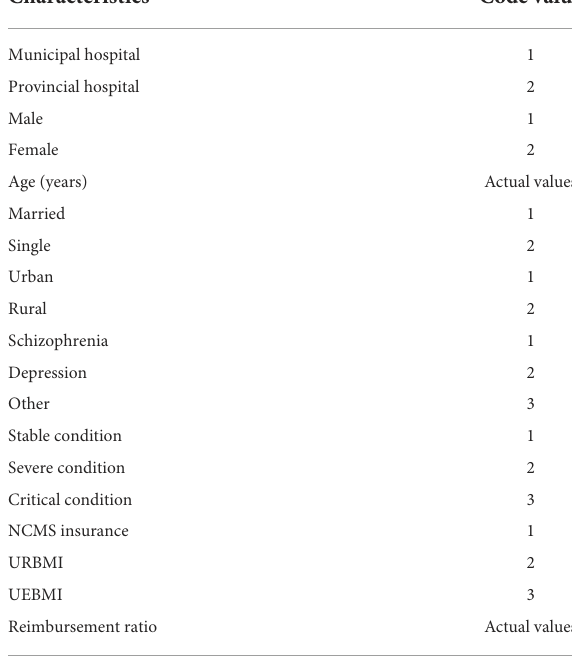
TABLE 2 The coding of sociodemographic and clinical